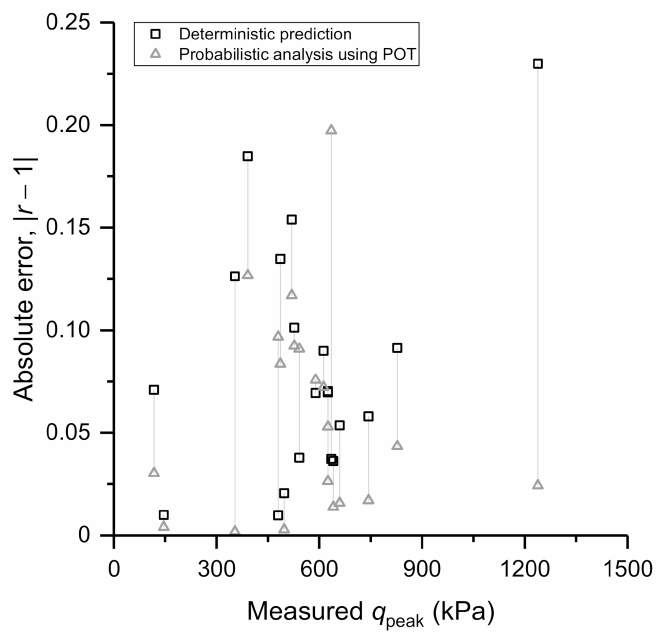
Figure 9. Performance of proposed approach for optimized assessment of q peak